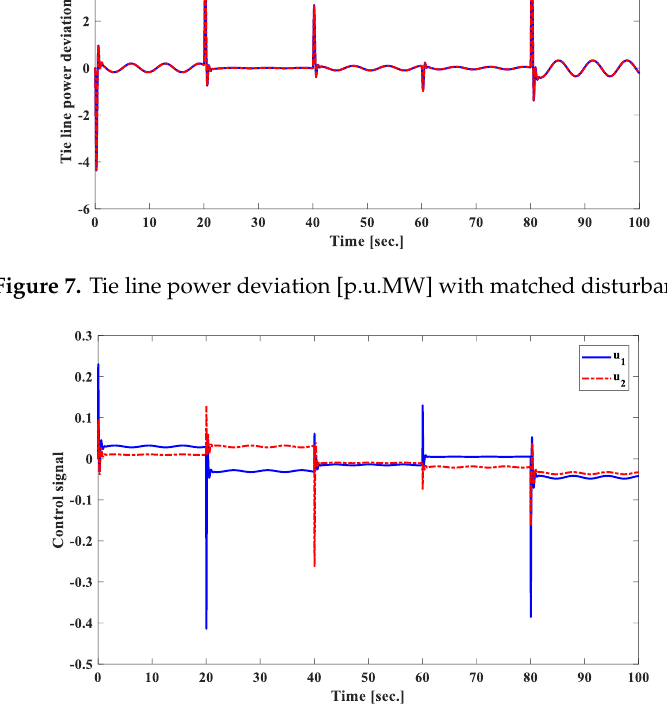
Figure 8. Control input [p.u.] of two control areas with matched disturbances.